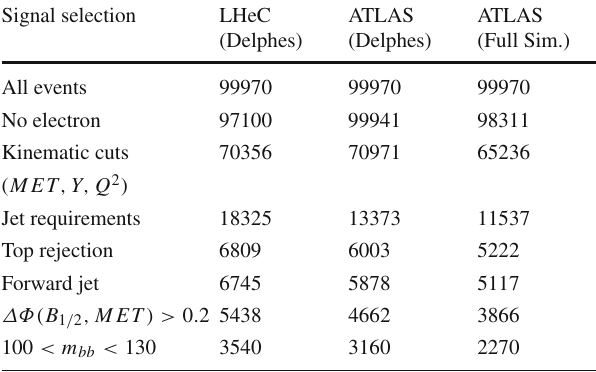
Table 4 Expected event yields for the signal and background processes in the signal region (100 < m bb < 130), for the ATLAS fast and full simulation ATLAS (Full Sim.)